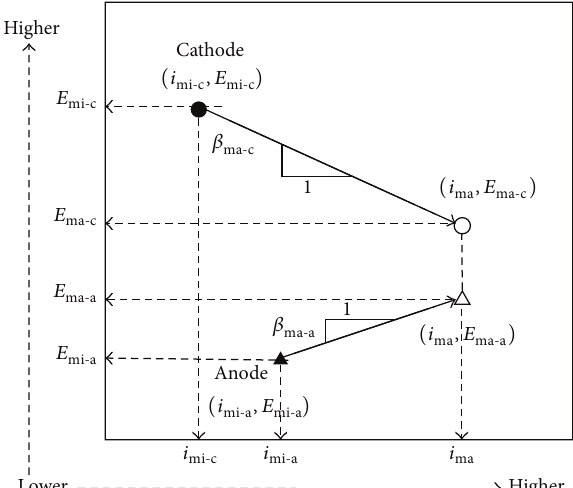
Figure 10: Definition of macrocell polarization slope of cathode and anode